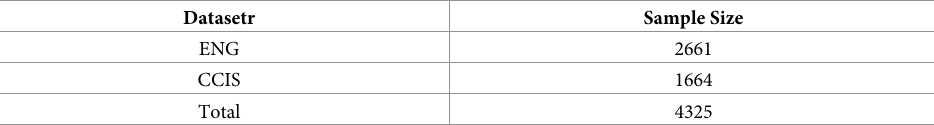
Table 2. The size of CCIS and ENG datasets.